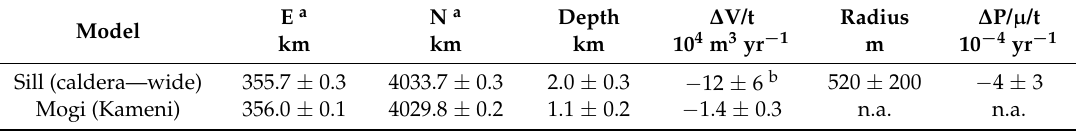
Figure 10. ( a – c ) Distribution of the deformation source location presented in this study, compared to previously published solutions. 2D posterior probability density functions of the two sources inverted are reported with 20% confidence contour. The mean models of this study are marked by a black star. Previous sources are reported as empty squares if referred to the unrest (inflation), filled squares if referred to the slow pre-unrest subsidence. Table 3. Mean values of the inverted source